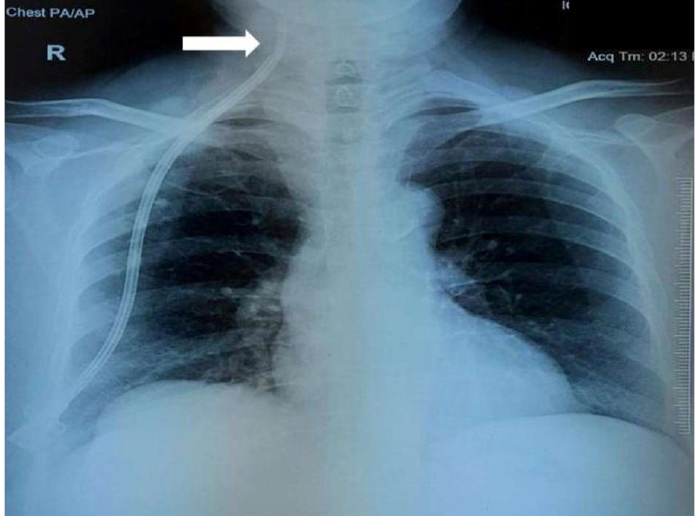
Figure 1. Chest X-ray film showed the TCC tip positioned superiorly, towards the head instead of downward towards the heart.